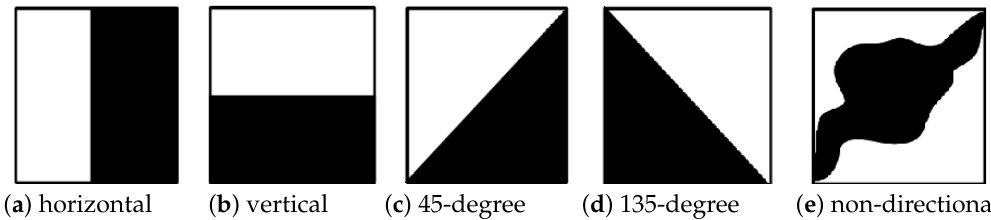
Figure 2. Types of edge directions in the edge histogram, in particular ( a ) the horizontal edge, ( b ) the vertical edge, ( c ) the 45-degree edge, ( d ) the 135-degree edge, and ( e ) the non-directional